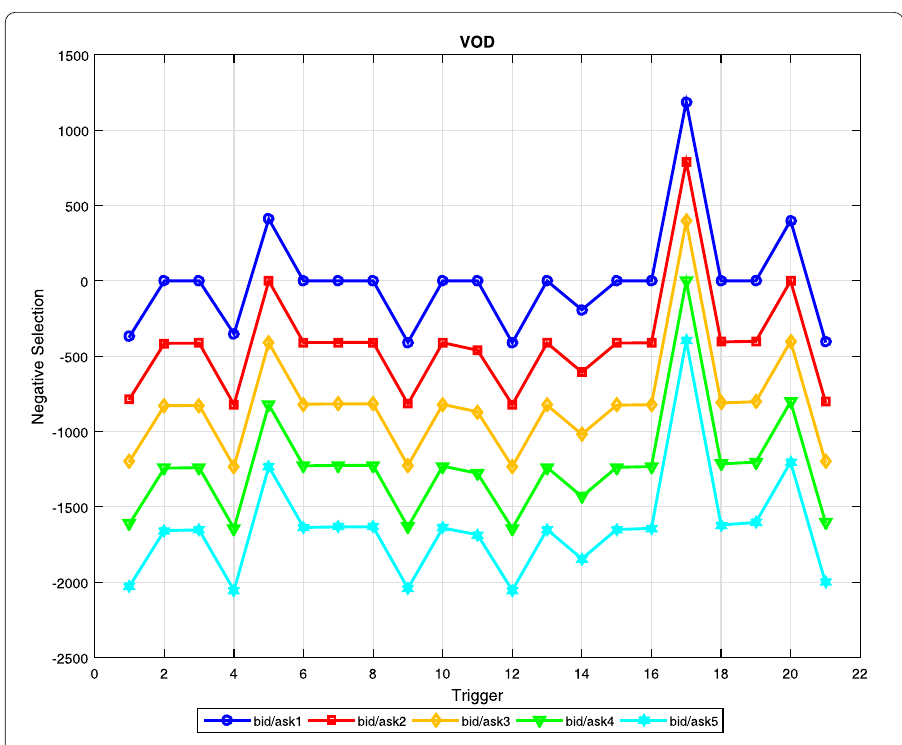
Figure 3 Comparison of Negative Selection for VOD by price